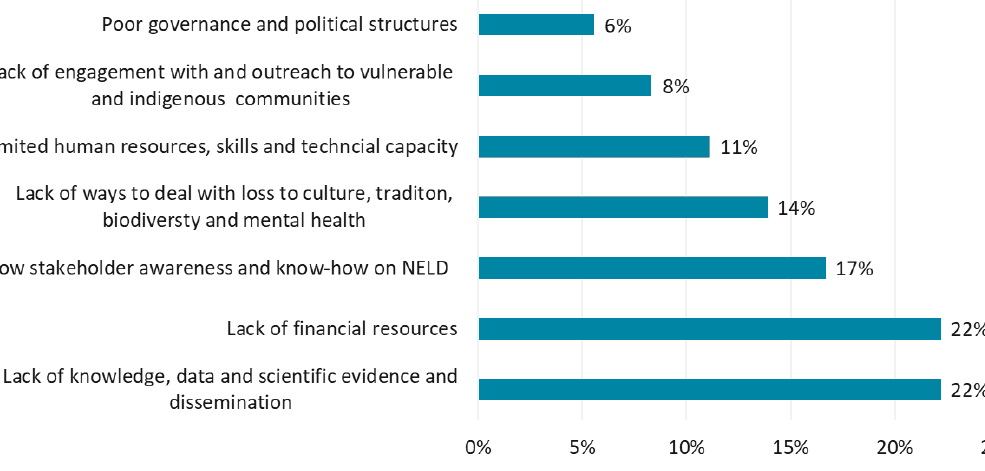
Figure 3. Policy challenges encountered by organisations in addressing NELD related to climate change impacts.